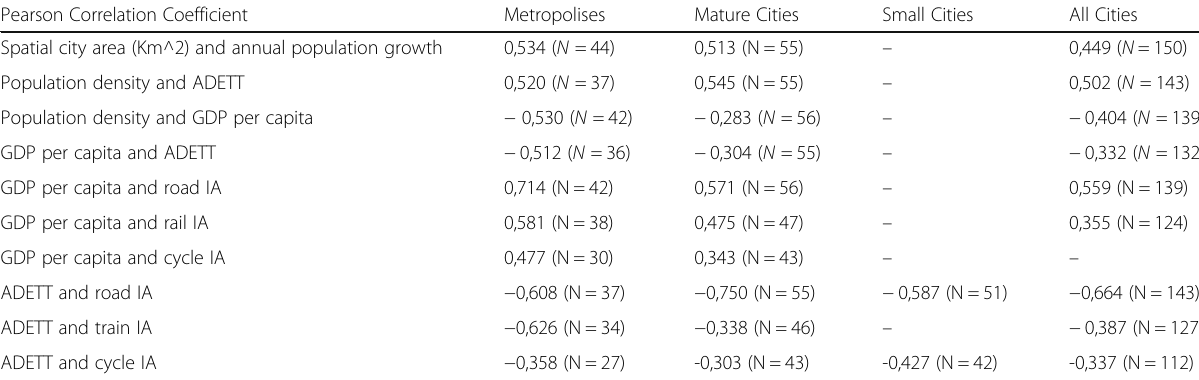
Table 1 Pearson correlation coefficient and number of samples (N) between different indicators Pearson Correlation Coefficient